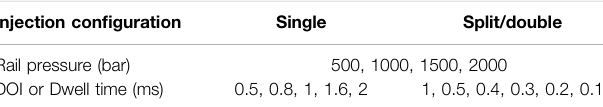
TABLE 2 | Summary of the test conditions for single and double injections performed with both MFM and BM.